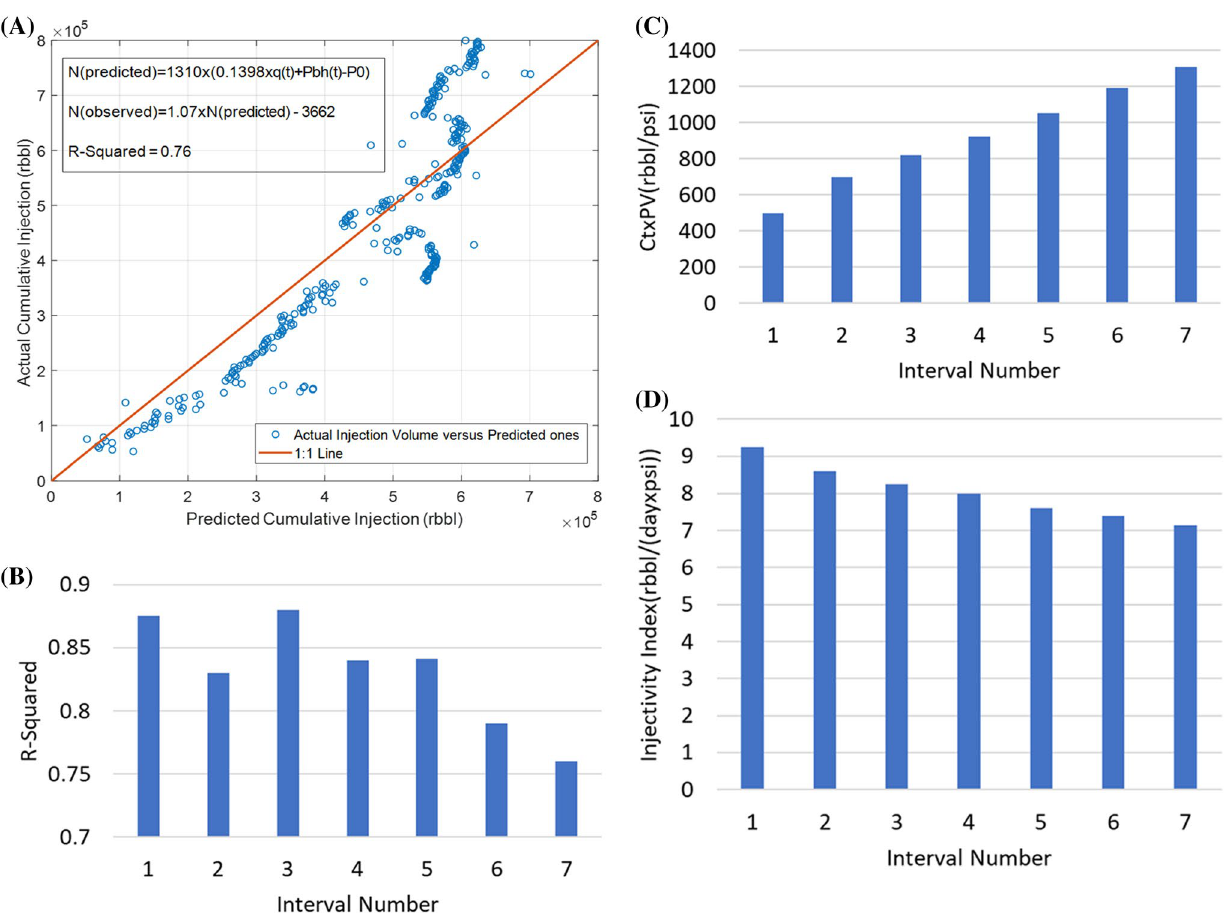
Fig. 9 a Actual (field) CO time intervals. c Estimation of pore volume × compressibility in dif- 2 injection volume versus fitted data using ferent time intervals. d Estimation of injectivity index in different simplified physics-based model for south lobe and the 1:1 line for time predicted versus actual data. b Estimation of R-squared in different